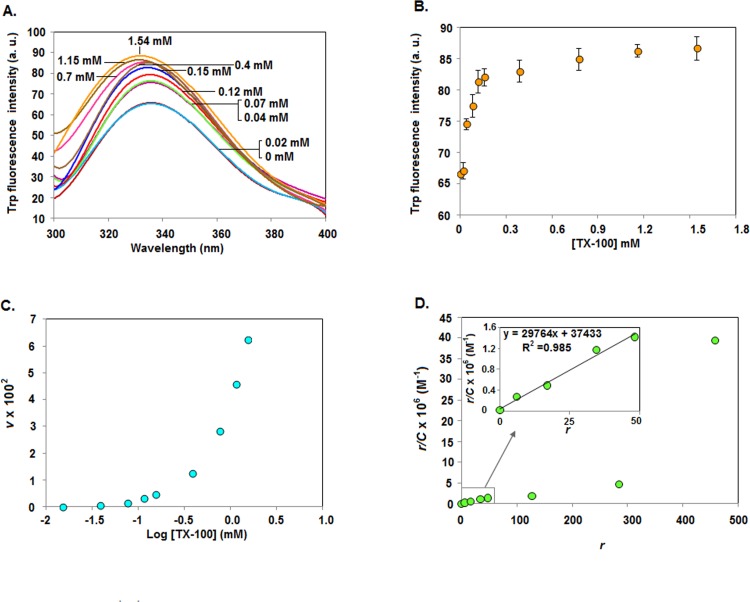
Binding of TX-100 to C9W.(A) The intrinsic Trp fluorescence spectra of C9W in the presence of 0–1.54 mM TX-100 (Tx). A set of spectra are shown here. (B) The Trp fluorescence intensity values of C9W at 336 nm, extracted from the fluorescence spectra in panel A, are plotted against the related TX-100 concentrations. (C) The average number of TX-100 molecule bound per C9W molecule (ν), determined using the Trp fluorescence intensity values stated in panel A and a standard equation [27], are plotted against the total concentration of added TX-100. (D) Scatchard plot showing the interaction between TX-100 and C9W has been developed as described in Materials and Methods. The inset plot, developed using the indicated values, is used to determine the C9W binding constant of TX-100.